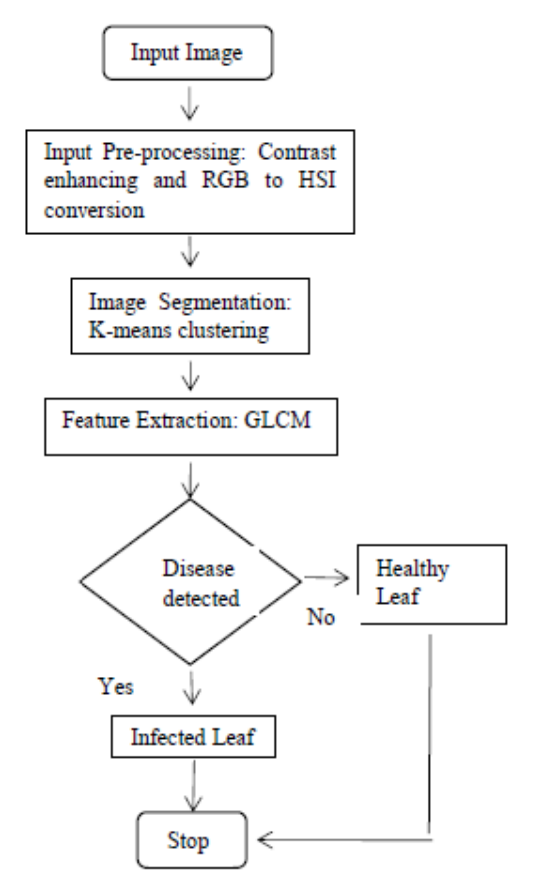
Figure 2. Algorithm of Leaf Disease Identification 2.2.2. Converting the image from RGB to HSI: Conversion of RGB to HSI is helpful for the colour description. RGB stands the colors in the form of red, green, blue and HSI is the hue saturation intensity. RGB is group of primary colors. To calculate the intensity average value of RGB is